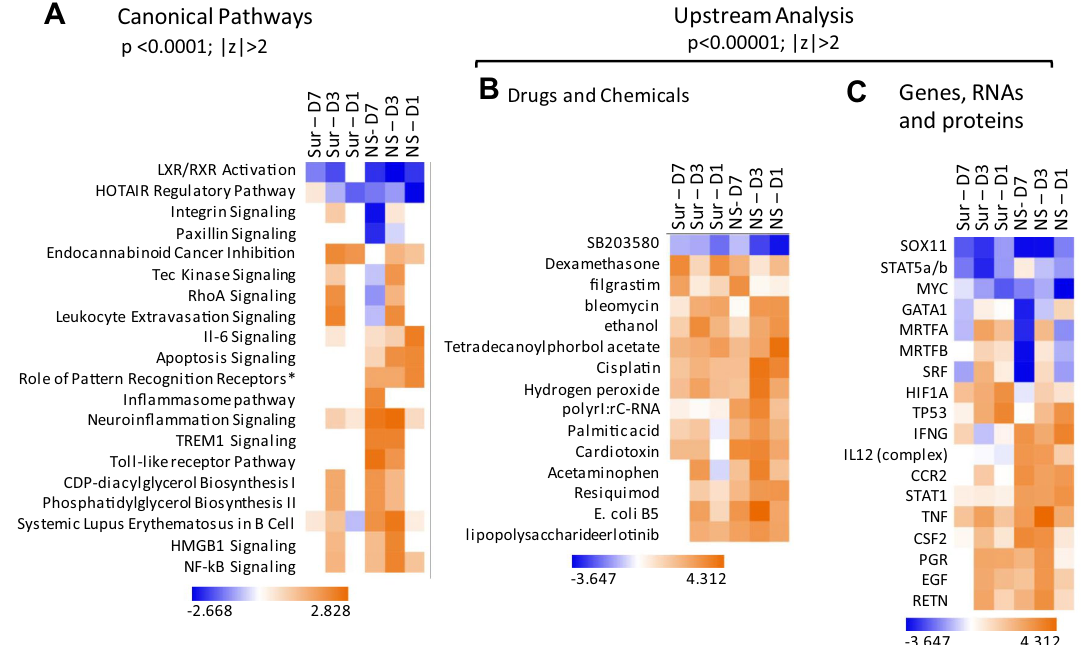
Figure 5. IPA comparison analysis predicted canonical functions and pathways differentially affected in survivors vs. decedents. Heat maps showing ( A ) canonical pathways and ( B , C ) Upstream Analysis terms significantly differentially activated (red) or repressed (blue) in any of the conditions. Hierarchical clustering was applied to both pathways and samples. The filtering criteria are shown on the clusters. Sur and NS stand for ‘survivors’ and ‘non-survivors or decedents’ respectively. Sur-D1 stands for genes differentially expressed at day 1 compared to baseline values in survivors; NS-D1 stands for genes differentially expressed at day 1 compared to baseline in decedents; similarly, the remaining labels could be